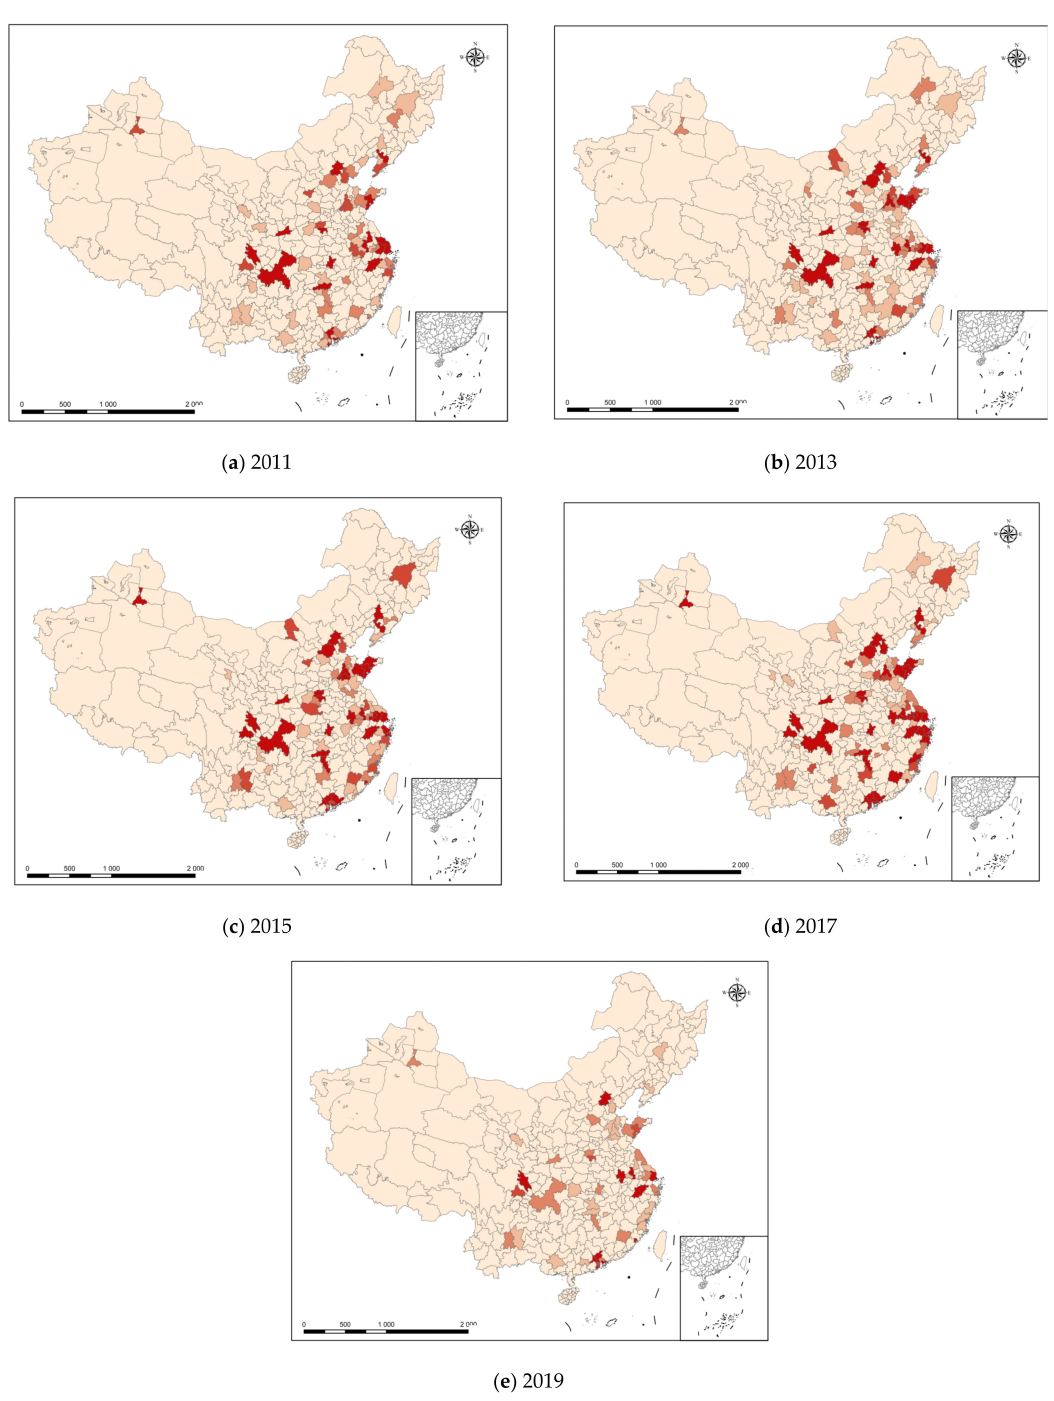
Figure 3. National Spatial Distribution of Green Invention Patents